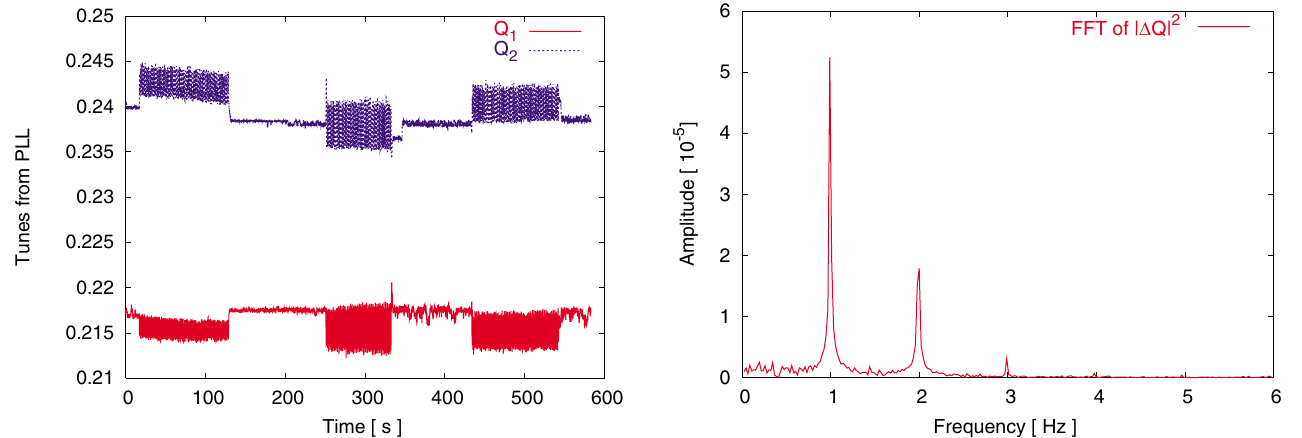
FIG. 1. (Color) PLL tune data of three modulations at injection.